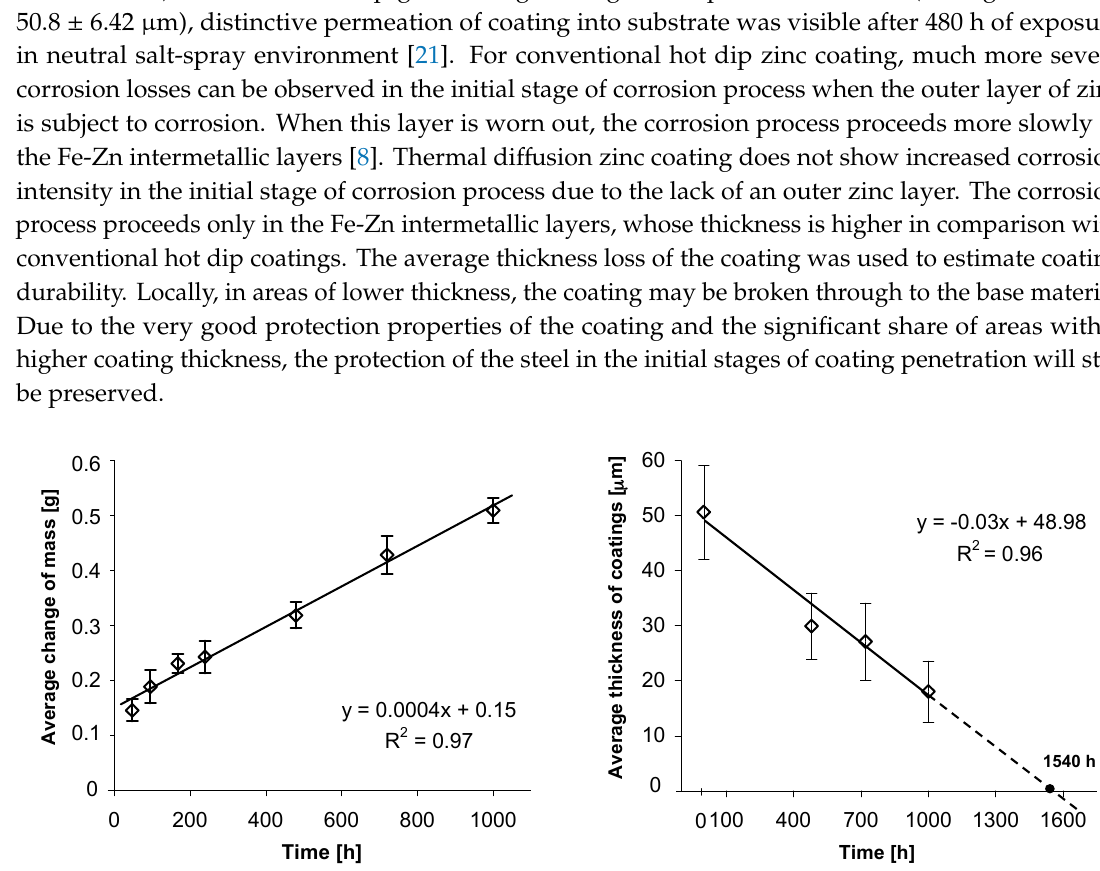
Figure 5. The appearance ( a ) and structure ( b ) of the thermal diffusion zinc coating after corrosion tests in a salt chamber.